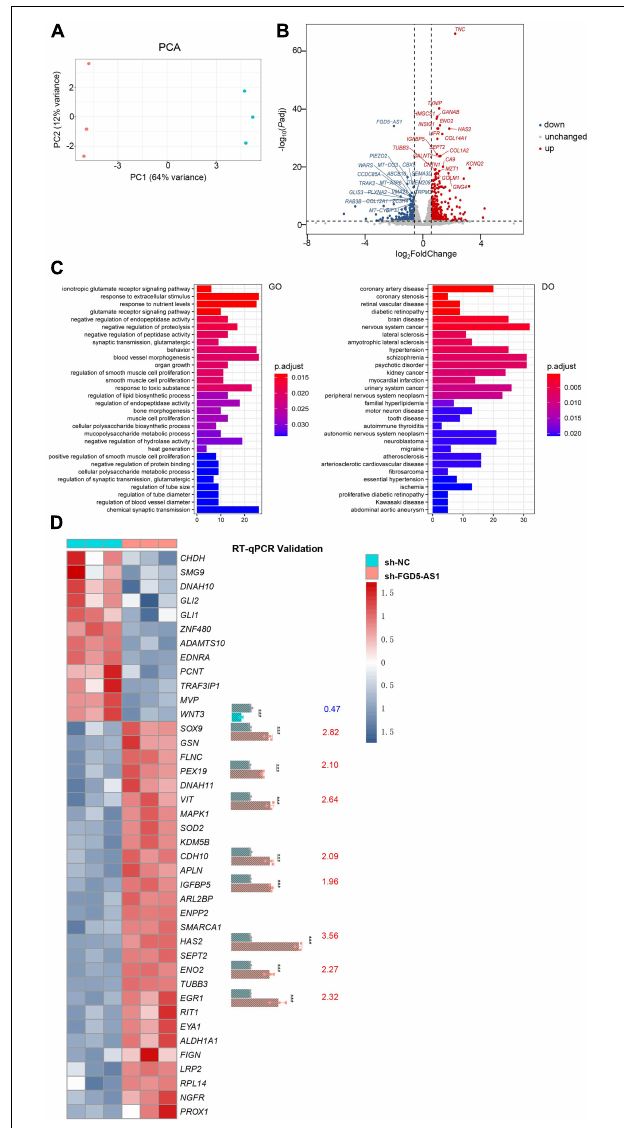
FIGURE 4 | RNA sequencing (RNAseq) analysis of FGD5-AS1 knockdown (KD) CCC-HEH-2 cells. (A) Principal component analysis (PCA) plot of RNAseq. Control and shRNA KD CCC-HEH-2 cell samples are shown in red and cyan , respectively. (B) Volcano plot of differential gene expression analysis between the control and the FGD5-AS1 KD CCC-HEH-2 cell line. Symbols of the top 20 significantly up/downregulated genes are labeled. (C) Gene Ontology (GO) and Disease Ontology (DO) enrichment analysis of the upregulated genes in RNAseq. (D) Heatmap of the 41 congenital heart disease (CHD)-related genes within differential expression in RNAseq. Nine of them were validated by RT-qPCR ( WNT3 , SOX9 , PEX19 , VIT , CDH11 , IGFBP5 , HAS2 , ENO2 , and EGR1 ), and the fold change values are labeled. n.s., not significant; The number of asterisks indicated the corresponding statistical significance ( p-value ). * p < 0.05; ** p < 0.01; *** p <